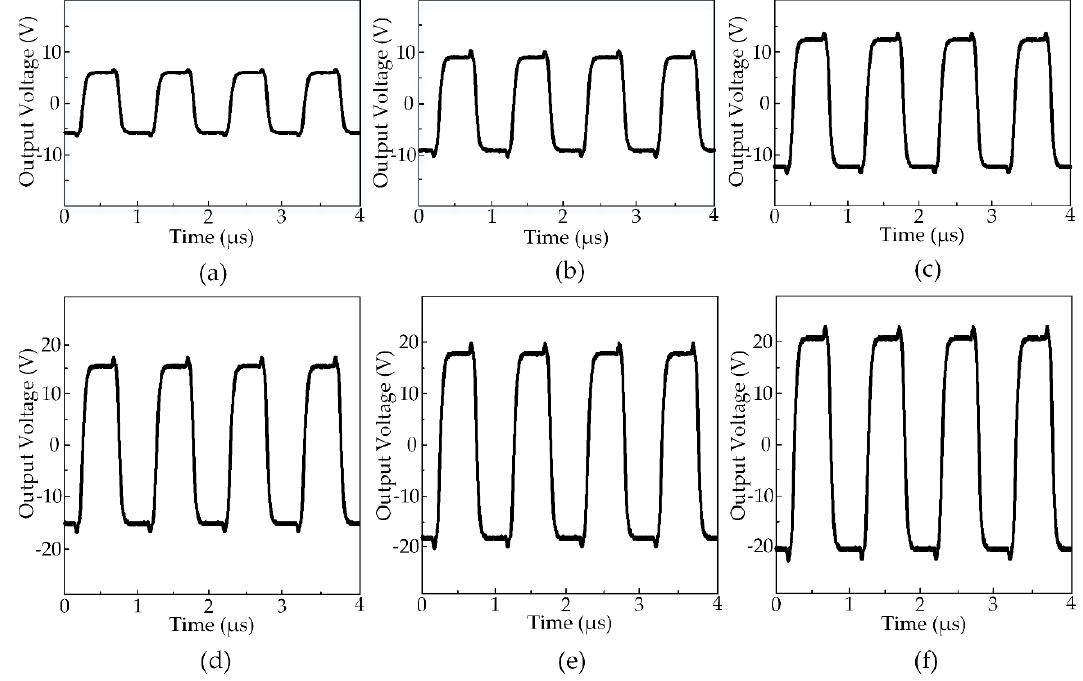
Figure 6. The output waveforms from HIFU circuit measured at various voltage amplitudes at 50% duty cycle: ( a ) ±6 V ( b ) ±9 V ( c ) ±12 V ( d ) ±15 V ( e ) ±18 V ( f ) ±21